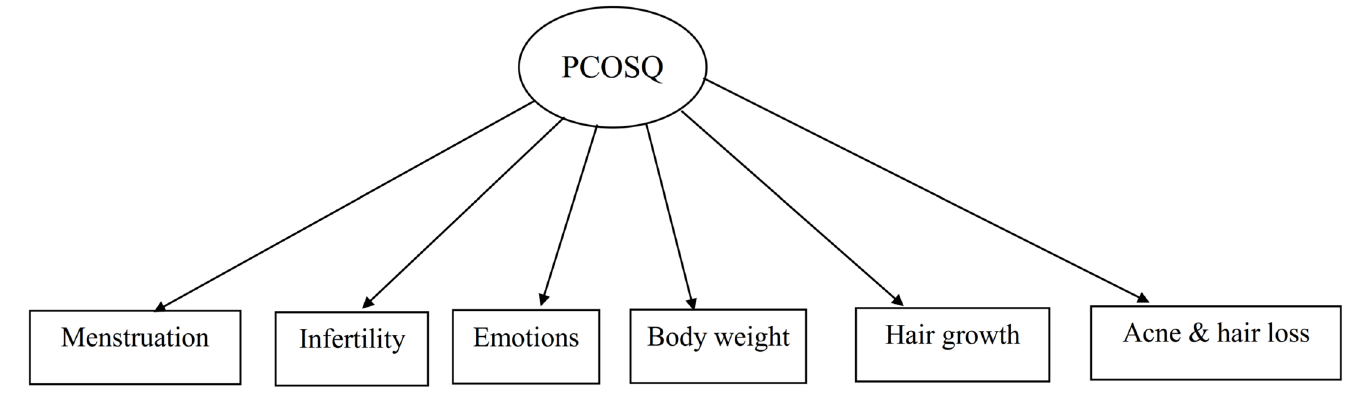
Fig 1. Priori structure for